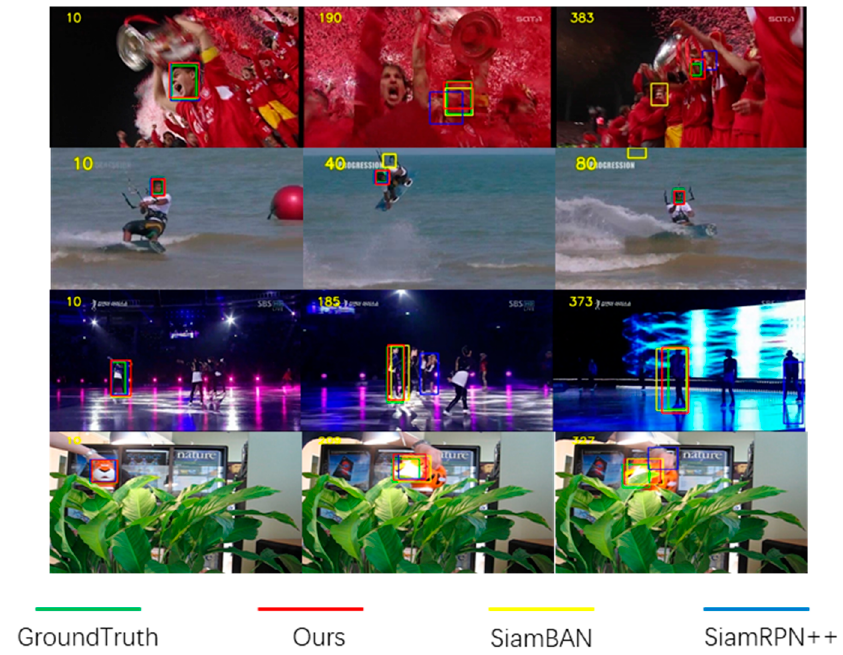
Figure 1. Visual comparison of TA-Siam with state-of-the-art trackers on four video sequences: soccer, kitesurf, skating1, motor-rolling. TA-Siam expresses our proposed Template Adjustment Siamese Network tracker. The number in the top left corner of each image represents the video frame number. Separately, these sequences represent four different challenges, respectively. Compared with SiamBAN [6] and SiamRPN++ [7], our proposed tracker can avoid bounding box drift and object loss phenomenon.